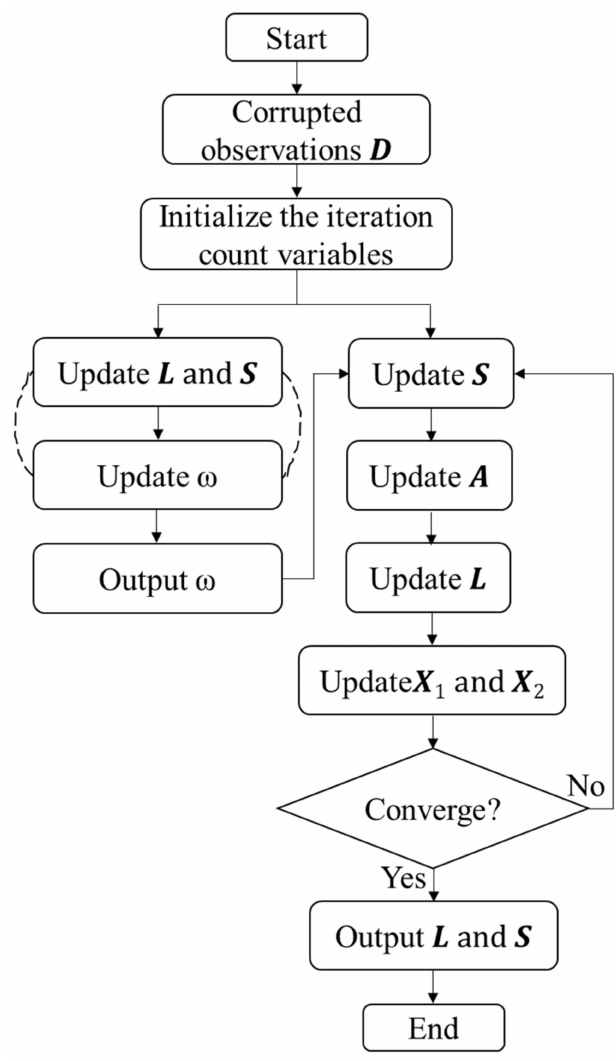
Figure 1. Flowchart of the proposed denoising